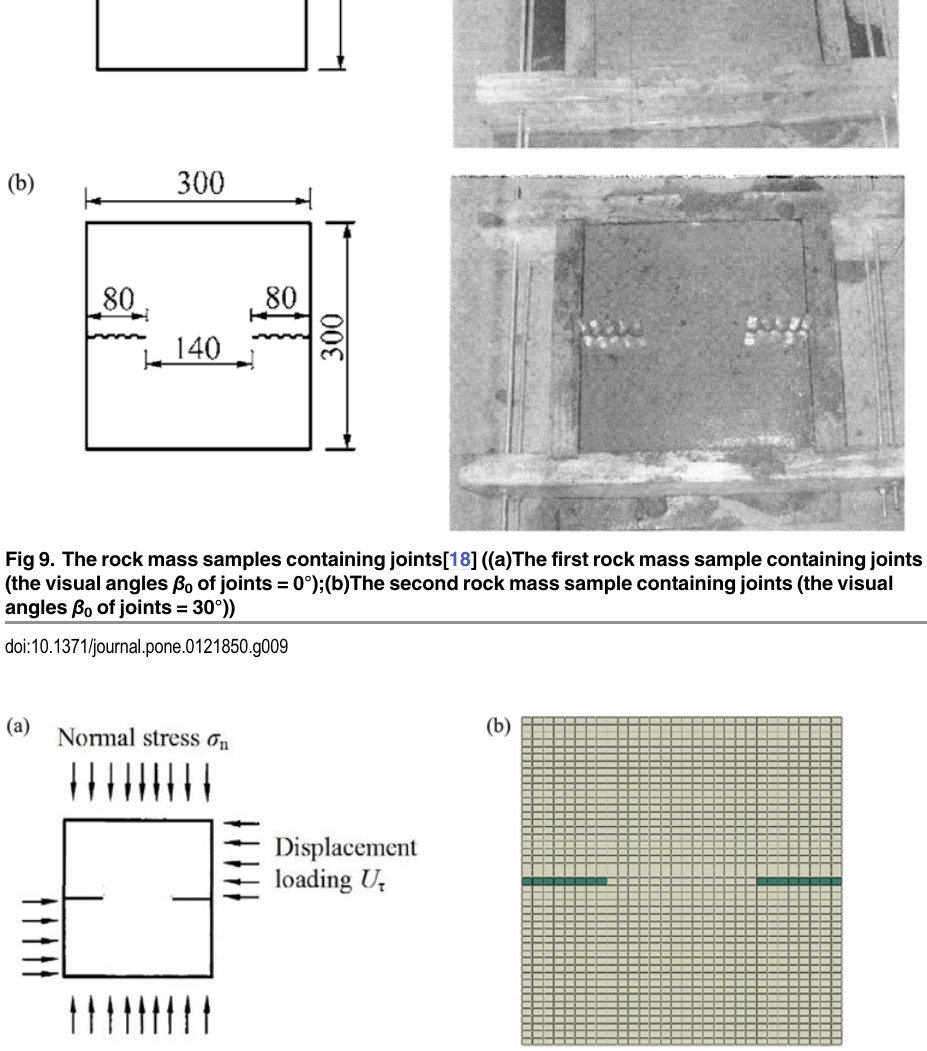
Fig 10. The boundary conditions and numerical model((a)The boundary conditions of jointed rock direct shear experiment;(b) The numerical model calculated by proposed constitutive model)